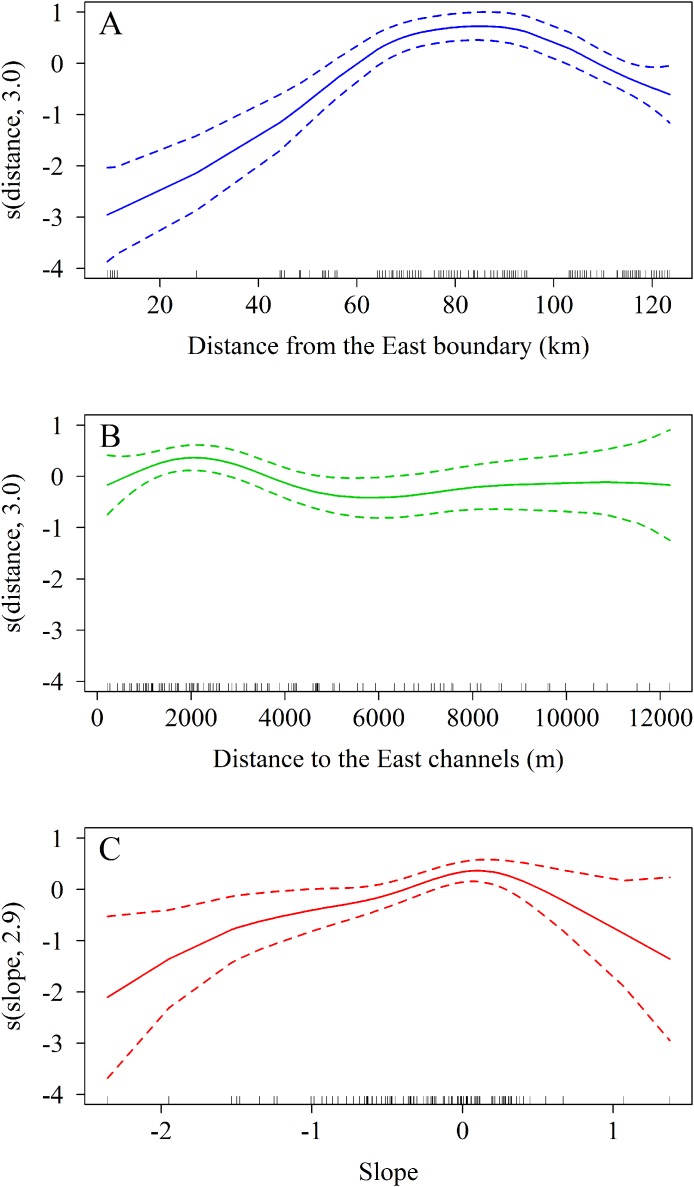
Results of truncated zero GAM applied to Acropora palmata colonies respective to geographical position.(A) The distance from the Eastern limit of the study area. (B) The distance to the channel closest to the East of the reef crests. (C) The slope (orientation) of the reef crests. The data was analyzed with a zero-truncated generalized additive model (GAM) with a negative binomial distribution. The solid line indicates the smoothed trend and the dashed lines ± 2 the standard error.